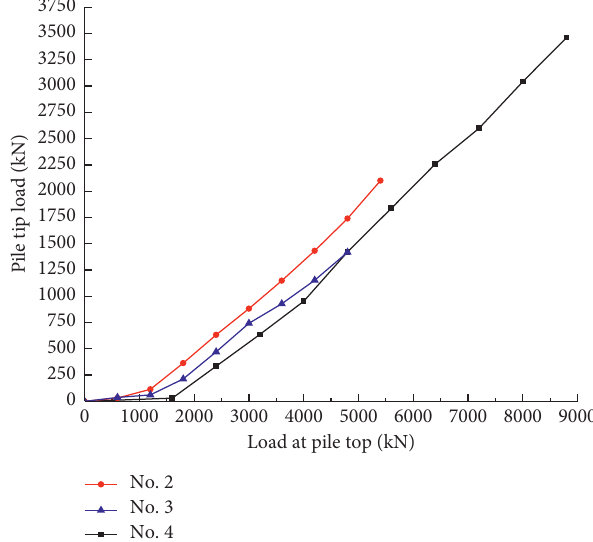
Figure 14: Variation curve of pile tip resistance under different loading steps. (a) No. 1 pile. (b) No. 2 pile. (c) No. 3 pile. (d) No. 4 pile.